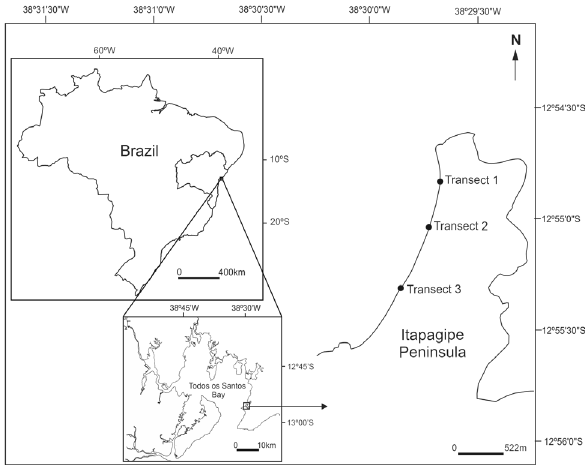
Figure 1. Study area and transects location on Ribeira beach (Bahia,